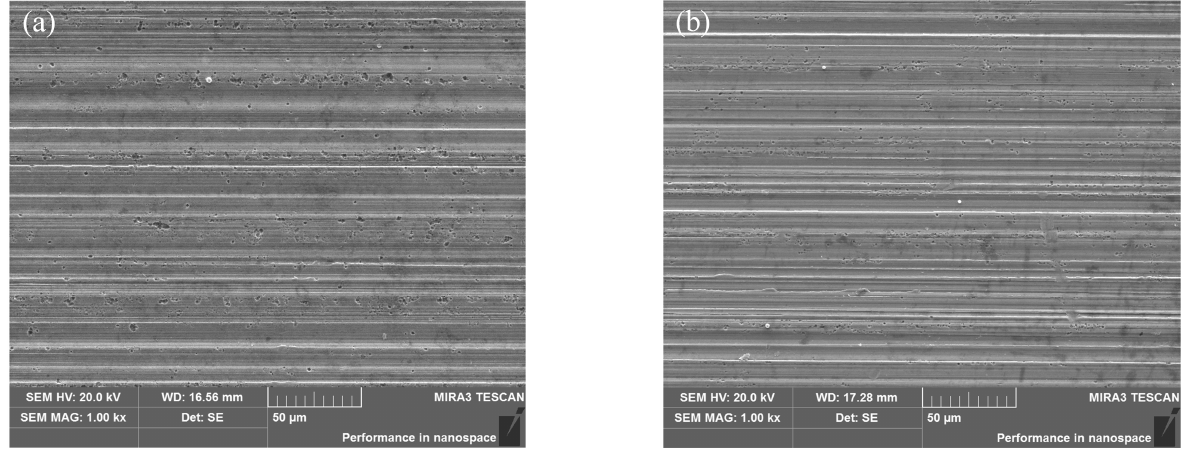
Figure 10. SEM of tooth flank after tempered grinding burn: ( a ) top of the tooth; ( b ) root of the tooth.